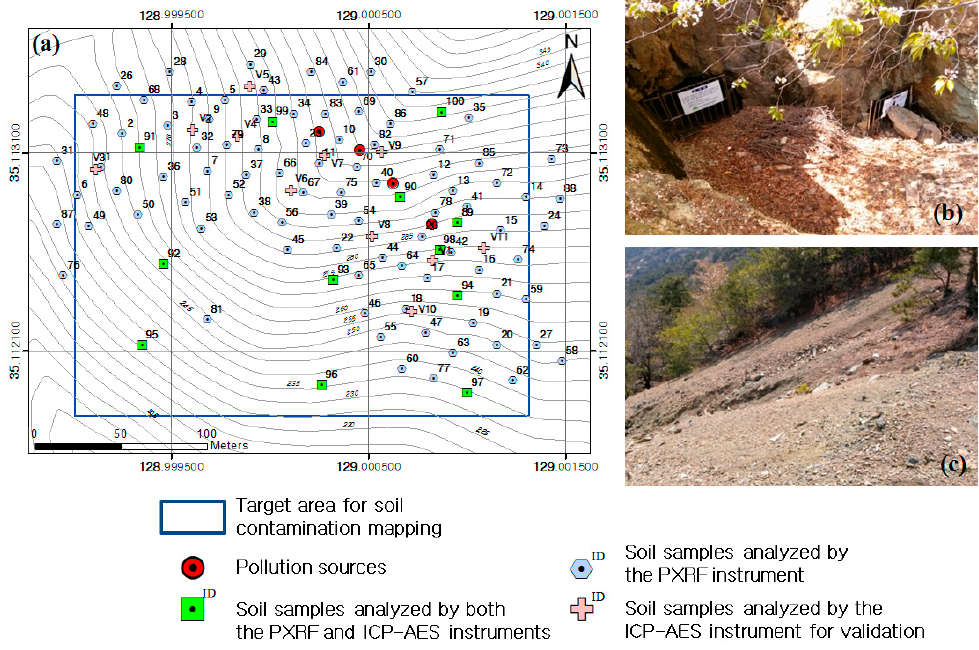
Figure 1. Study area: ( a ) Boundary of target mapping area (128°59'56.433''–129°0’4.726”